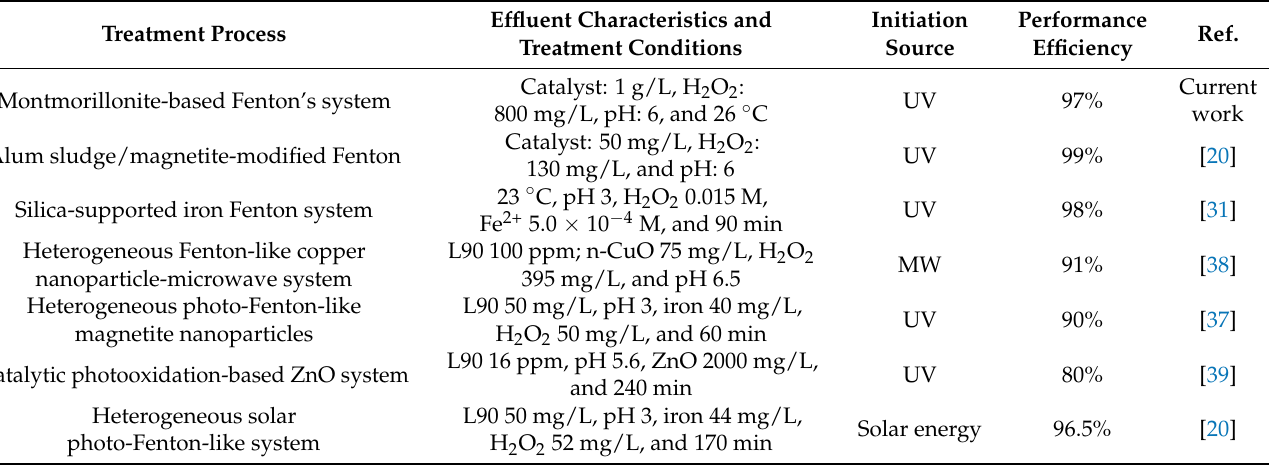
Table 6. Comparison of different oxidation systems for treating Lanox